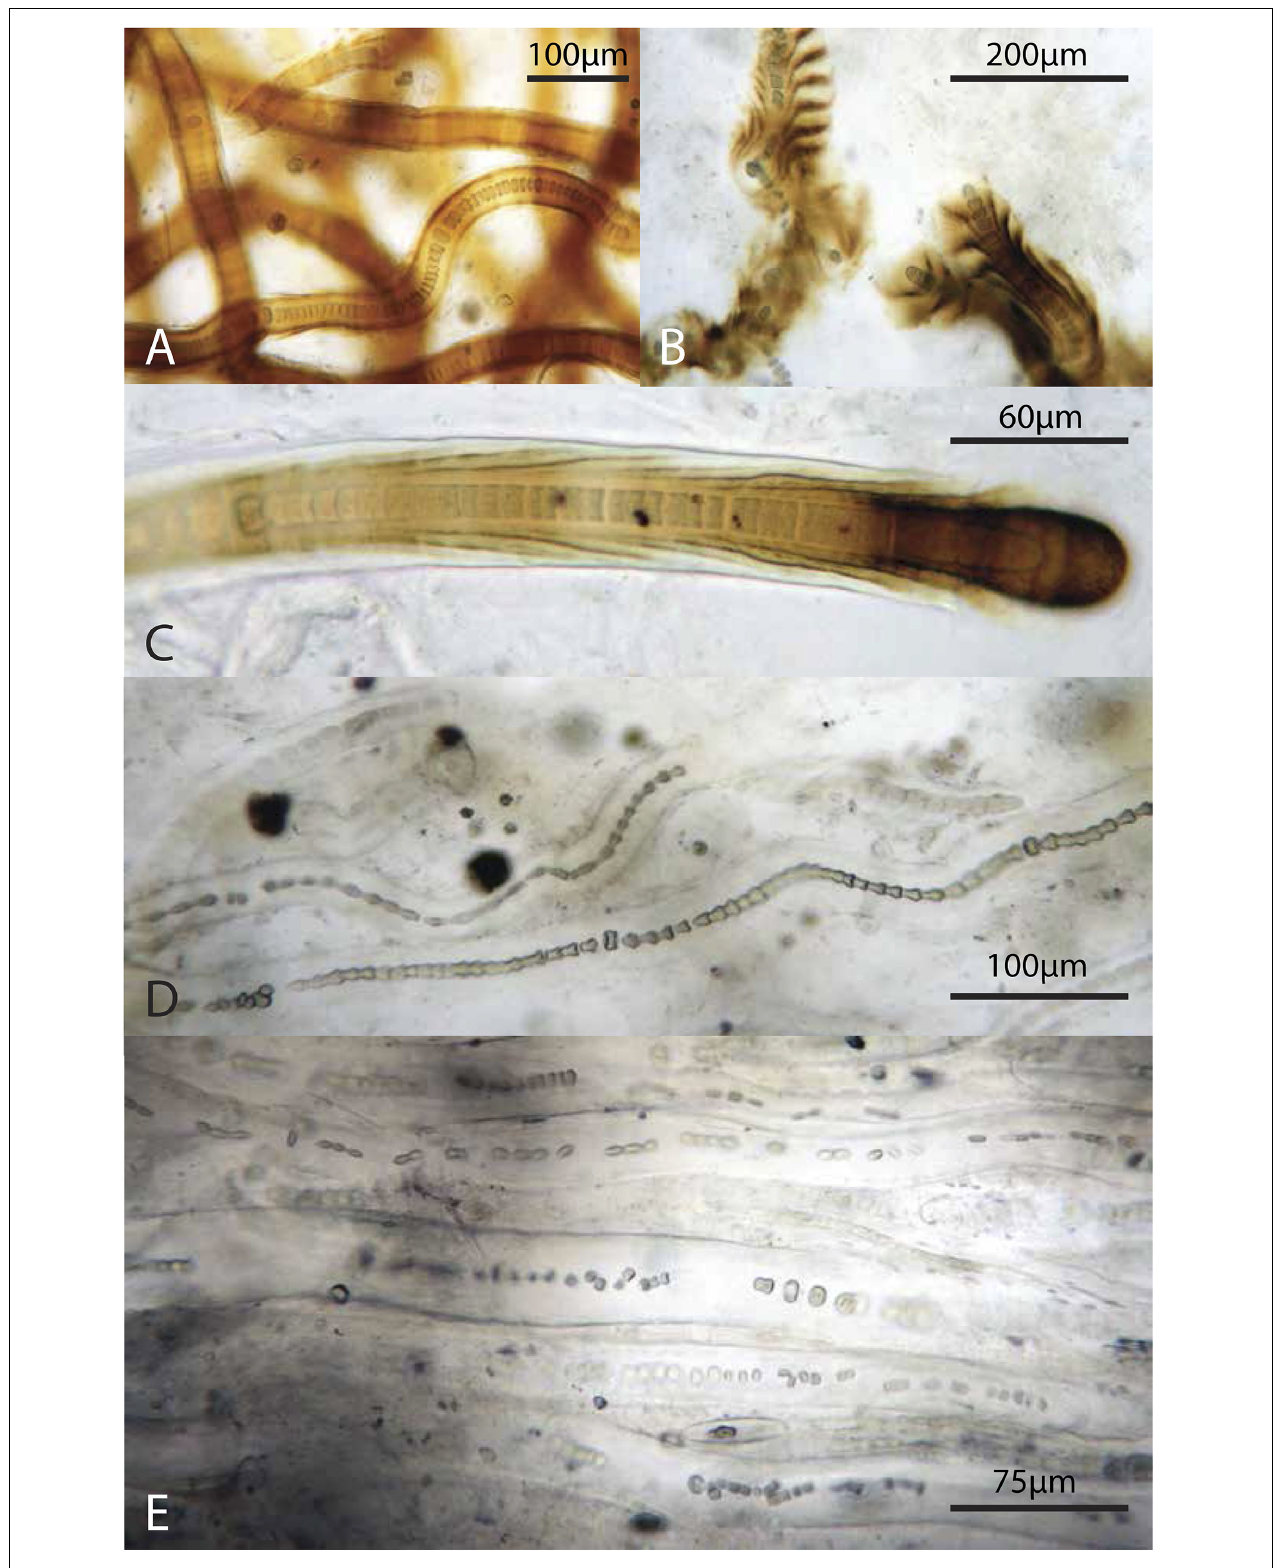
FIGURE 9 | Representative filamentous Cyanobacteria (cf. Scytonema ): (A–C) from the green layer, (D,E) from the pigment-poor layer below the dark green layer. Note varying degrees of preservation of trichomes.